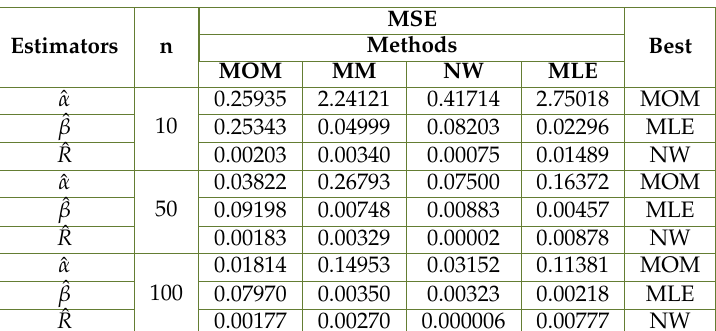
Table 5. Estimated values for ( α , β ) and ( R ) using ( E 4